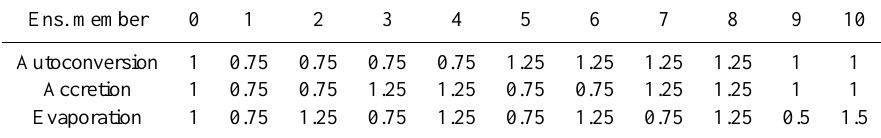
Table 2. Multiplying factors applied to the auto-conversion, accretion and evaporation tendencies, for each member of the E4 ensemble. Ens. member